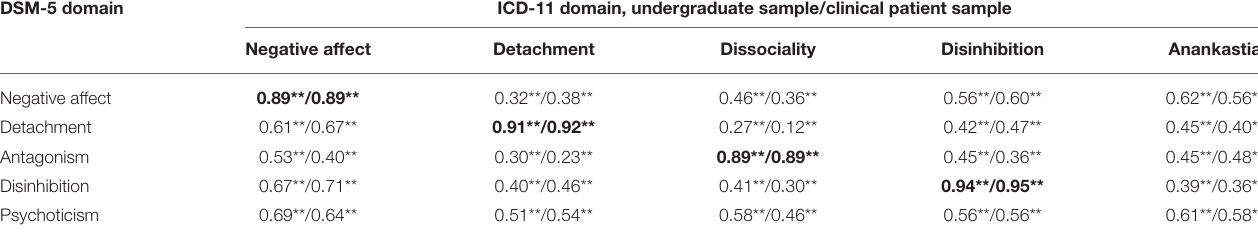
TABLE 4 | Correlations between DSM-5 section III domains and ICD-11